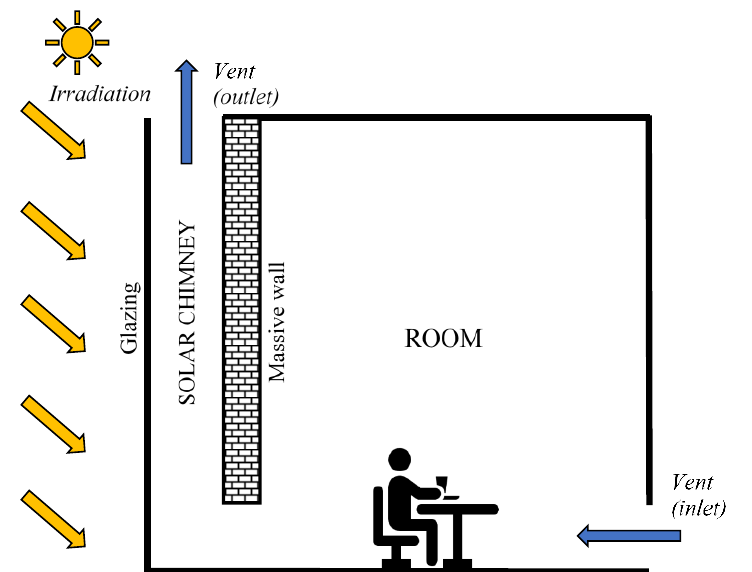
Figure 2. Typical arrangement of a solar chimney for natural ventilation and/or heating, attached to a room. Irradiation is captured through a special-purpose wall system (massive wall with absorber surface, glazing, …), forming a channel , or cavity , or chimney …